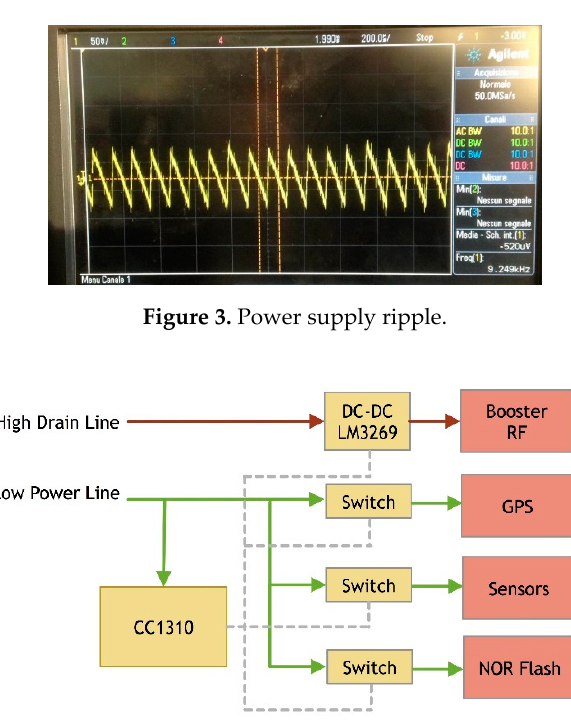
Figure 2. Spurious frequencies from a continuous wave due to the linear power noise.